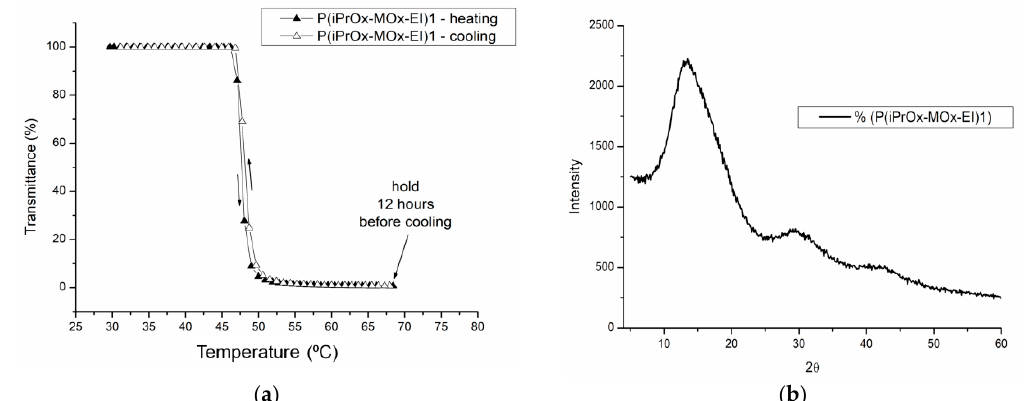
Figure 12. ( a ) Transmittance-temperature dependence of aqueous solutions of P(iPrOx-MOx-EI)1 (c = 5 g/L) with 12 h of incubation at 70 °C before cooling and ( b ) X-ray diffraction curves of P(iPrOx-MOx-EI)1 incubated for 12 h at 70 °C.